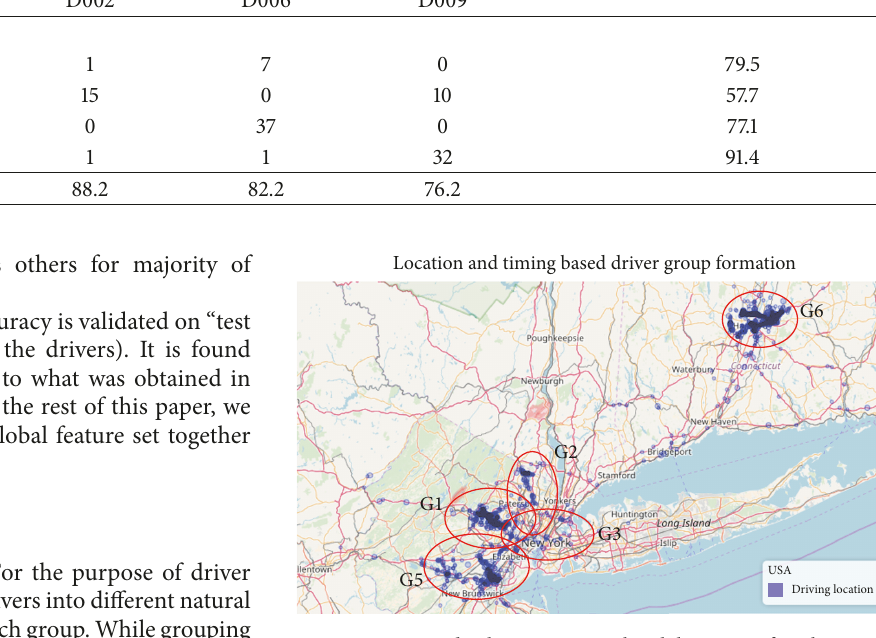
Figure 3: Map displaying geographical locations for the group of drivers [typical journey localities for each group of drivers are